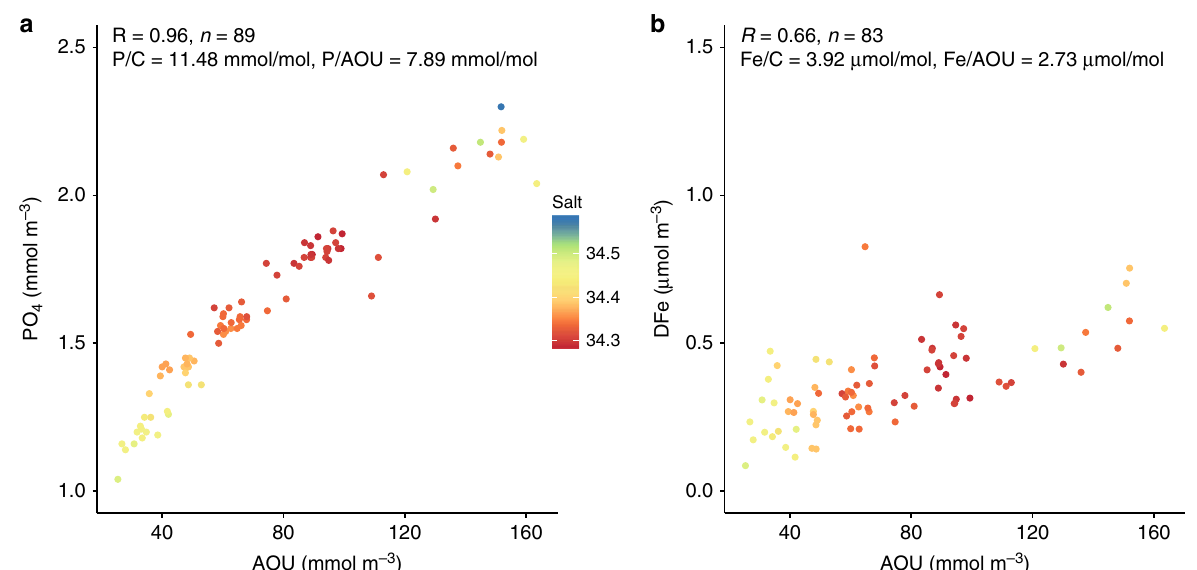
Fig. 2 Linking phosphate and dissolved iron to apparent oxygen utilisation. Plots of PO 4 (phosphate) and DFe (dissolved iron) observations against AOU (apparent oxygen utilisation) observations between the σ 0 = 26.8 – 27.0 isopycnal layers along the P16S transect through the South Paci fi c Ocean, performed with a Type II regression. Salinity for each sample is coloured